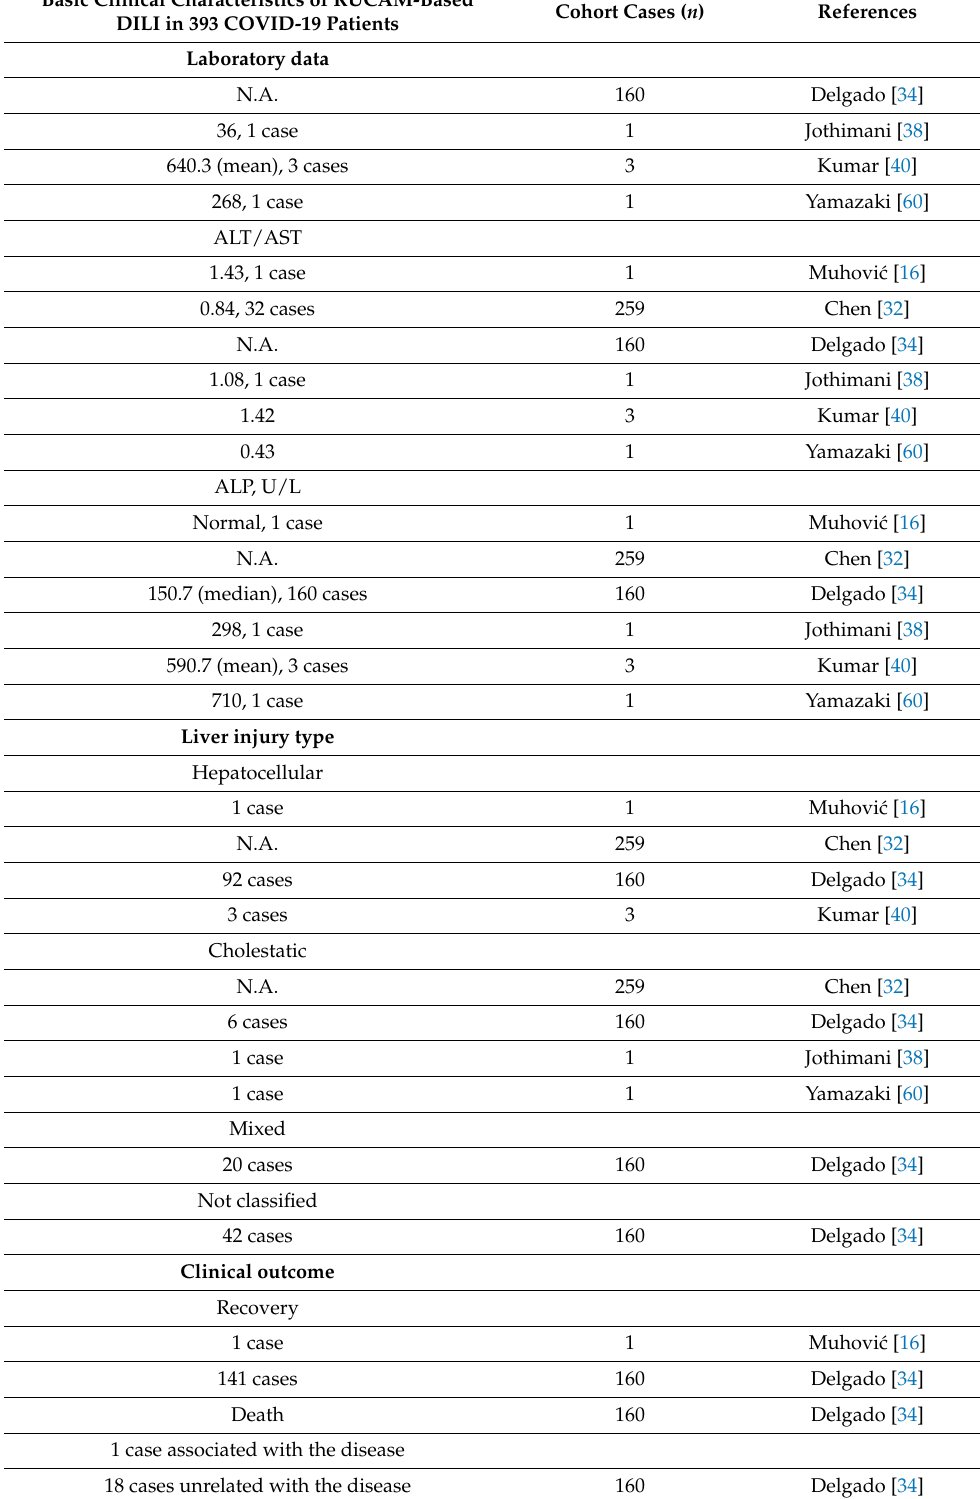
Table 3. Cont. Basic Clinical Characteristics of RUCAM-Based DILI in 393 COVID-19